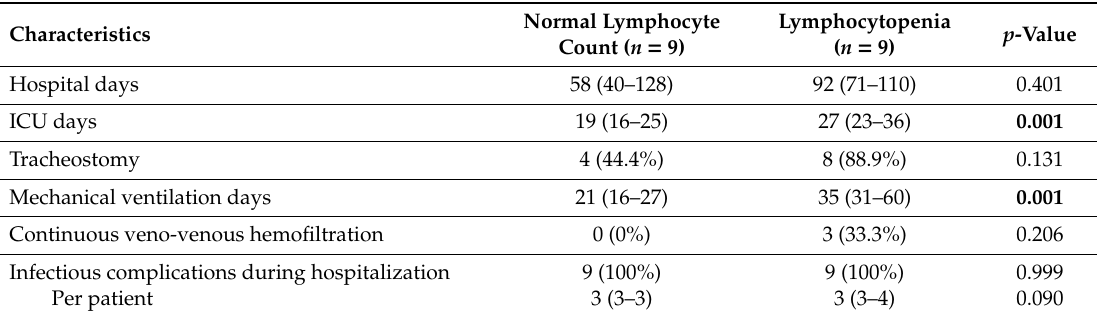
Figure 3. C-reactive protein levels and lymphocyte counts in clinically identified PICS patients (clinical PICS) in red and other CCI patients (no PICS) in green. Grey areas depict reference values. Data are presented as median with interquartile range. Table 4. Outcome comparison of clinical PICS patients with lymphocytopenia ** versus clinical PICS patients without lymphocytopenia.